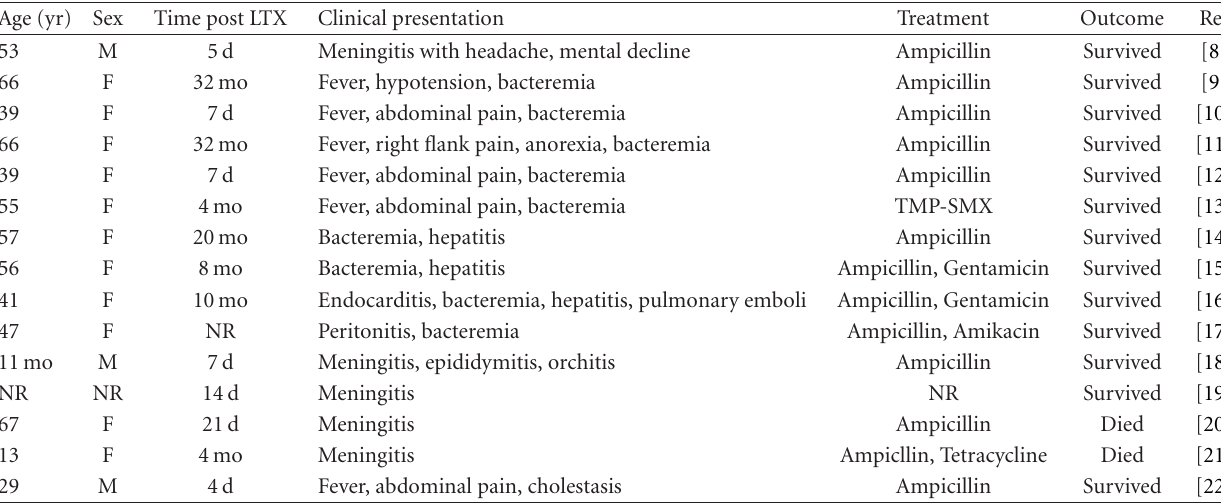
Table 2: Cases of listeria infection following liver